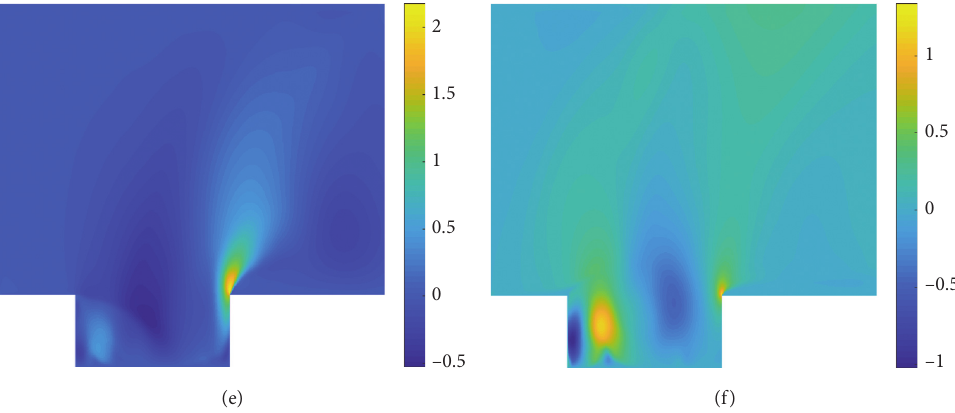
� 98.26), (b) DNS ( tU ∞ / L ∞ /